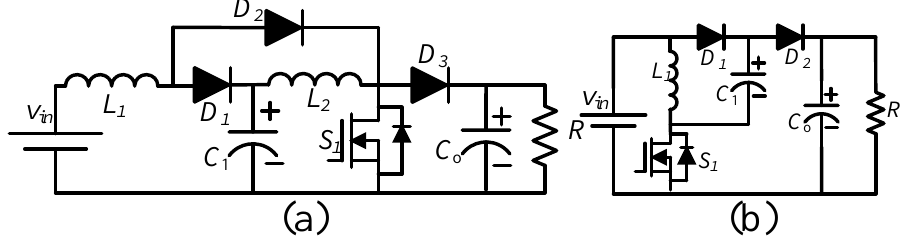
Figure 1. ( a ) A boosting circuit, and ( b ) a Luo